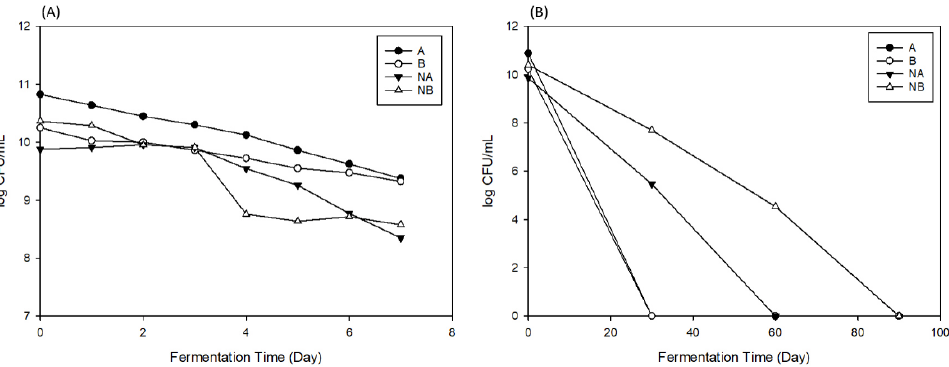
Figure 3. The growth curve of yeast and lactic acid bacteria during secondary fermentation in soy sauce in a short period ( A ) and long period ( B ) of time.